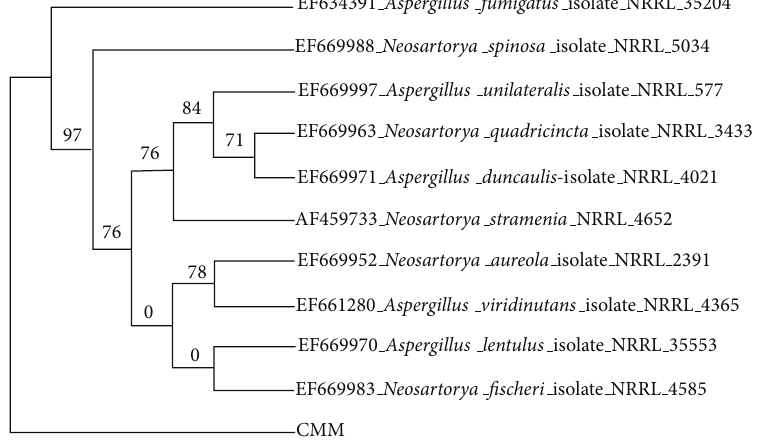
Figure 1: Characterization and phylogenetic tree of ITS sequences of Aspergillus fumigatus NITDGPKA3.